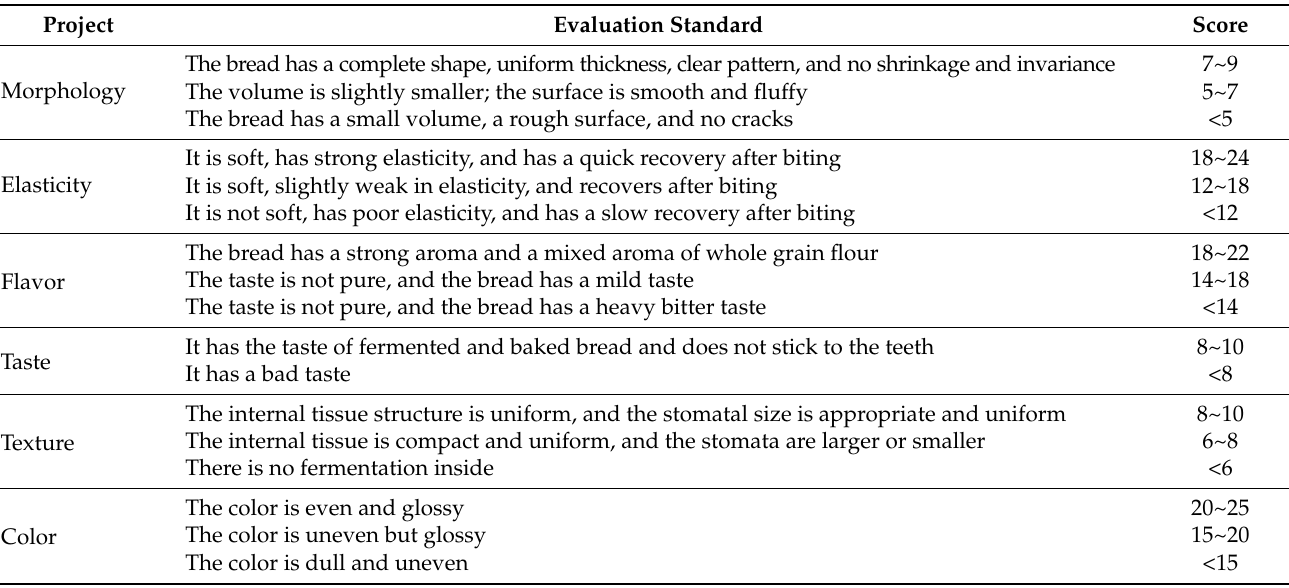
Table 1. Scoring standard of the bread’s sensory